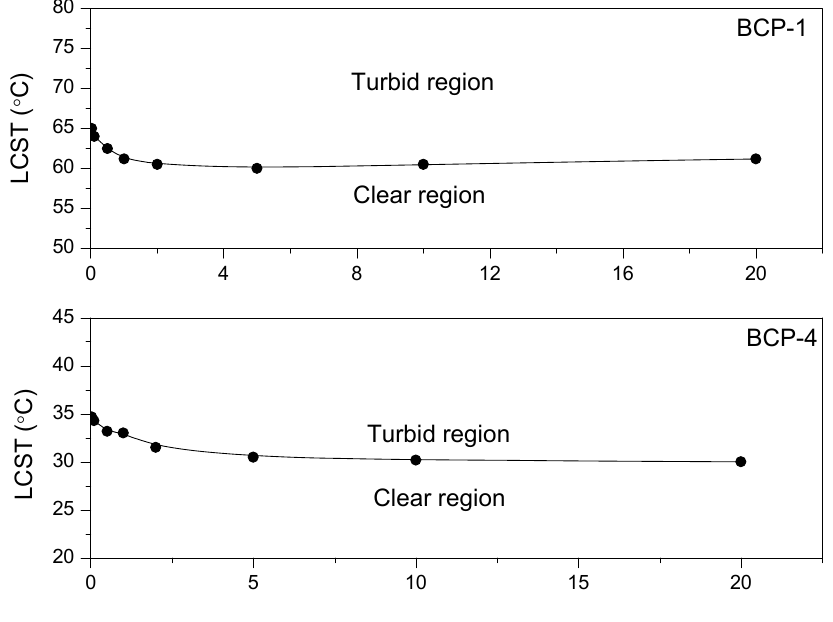
Figure 4. Effect of polymer concentration on the LCST in